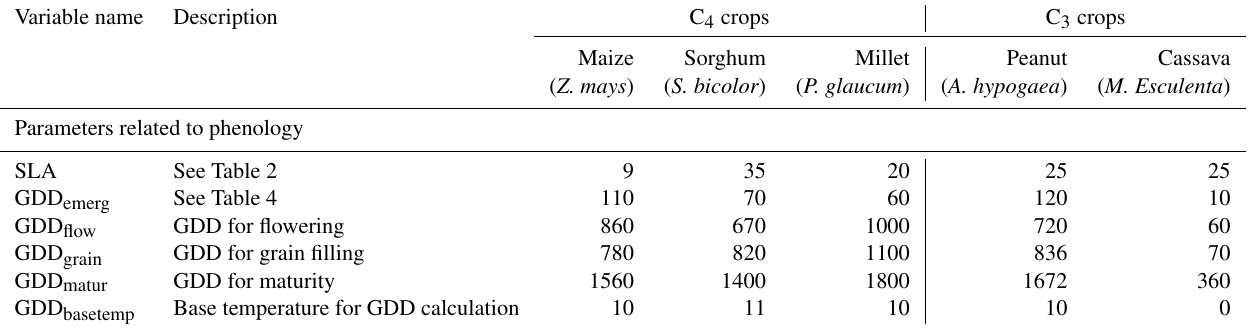
Table 5. Plant parameters that describe phenology and ontology/yield in the PlaMo x vegetation model for agricultural simulations (taken from the WOFOST model v.6.1 http://github.com/ajwdewit/WOFOST_crop_parameters, last access: 16 June